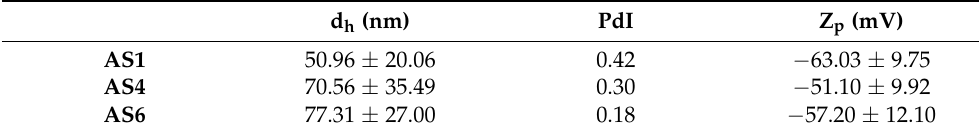
Table 4. Hydrodynamic diameters (d h s), polydispersions (PdIs), and zeta potentials (Z p s) of micelle formulations AS1, AS4, and AS6.